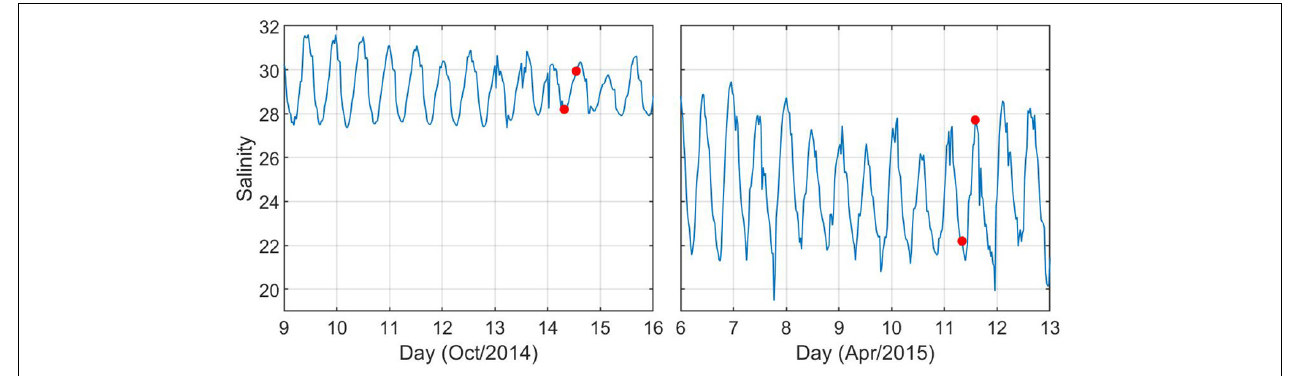
FIGURE 8 | Time series of salinity at oceanographic mooring GCE6 at the main channel of Doboy Sound (see Figure 1 for location) during October 2014 and April 2015 collections. Red circles indicate timing of sample